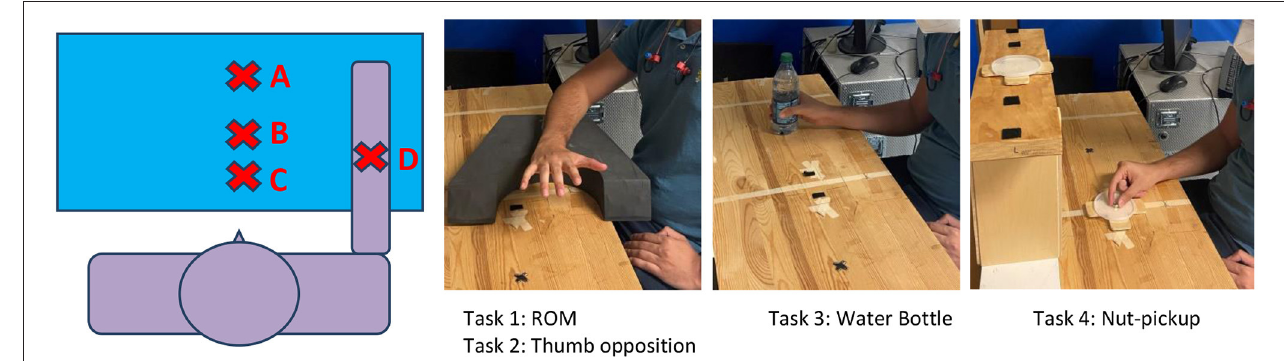
FIGURE 4 | Subjects were seated in front of a testing table. Position A is the target location of the Nut-Pickup task, at shoulder height. Position B is the starting location of the nut. Position C is the start position for all tasks. Position D is the start location of the water bottle. The forward distances from the subject to positions B, C, and D were 11”, 6”, and 8” respectively. The forward distance to position A was determined by the length of the subject’s outstretched arm at 90 deg of shoulder elevation and full elbow extension (at 100% of reach).